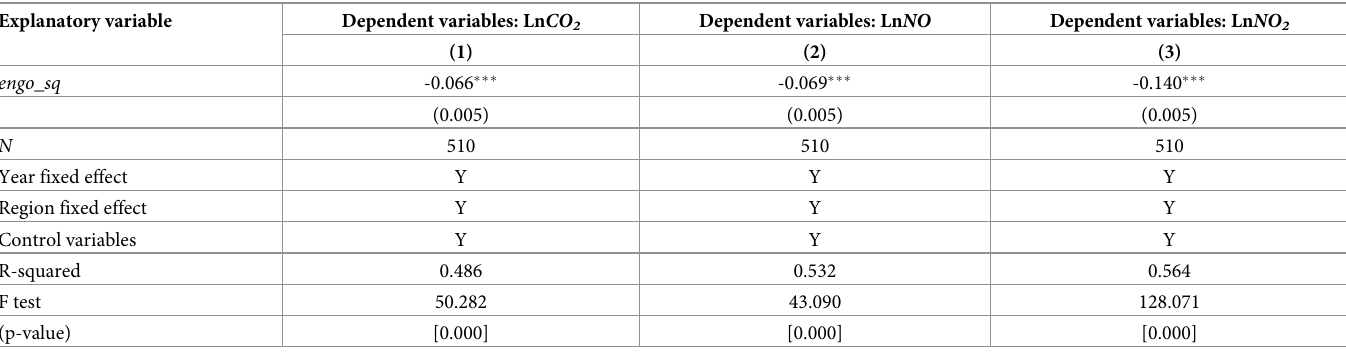
Table 6. The mitigation effect of ENGOs on other air pollutants